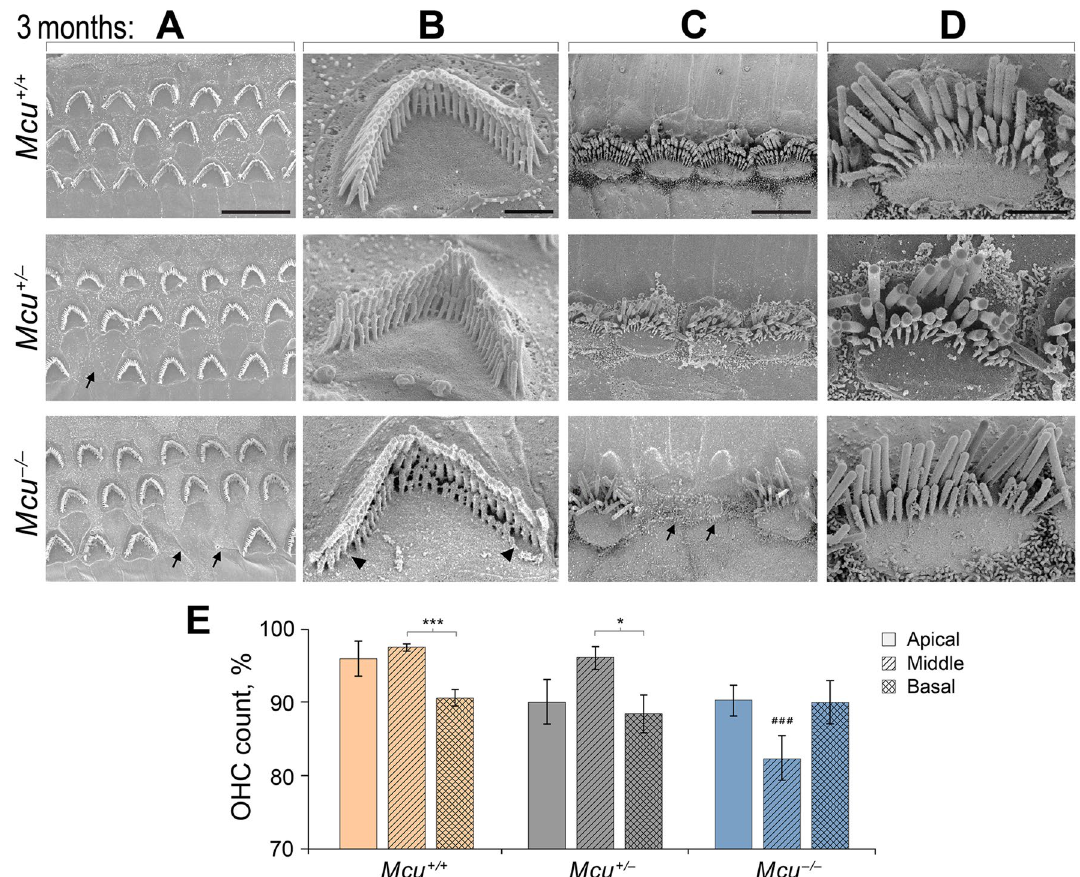
Figure 7. Loss of hair cells in adult Mcu −/− mouse cochlea. ( A – D ) Representative scanning electron micrographs of cochlear hair cells acquired from Mcu + / + (top row), Mcu + /− (middle row), and Mcu −/− FVB/ NJ mice (bottom panel) at P88–P92 time point. ( A ) The typical three-row arrangement of OHCs, ( B ) single OHC stereocilia at high magnification, ( C ) the single row of IHCs, and ( D ) single IHC stereocilia at high magnification are shown. Note the absence of the third (shortest) row of stereocilia in Mcu −/− mice. The arrows in ( A ) and ( C ) indicate missing sensory hair cells and the arrowheads in B indicate the degenerating shortest row of stereocilia in OHCs. ( E ) The SEM images were categorized based on their cochlear region (apical, middle, and basal turn), and the percentage of missing OHCs were plotted (mean ± SEM). ### p < 0.001 in comparison to the middle region of Mcu + / + and Mcu + /− mice, * p < 0.05, *** p < 0.001, Kruskal–Wallis with Dunn’s multiple comparison tests. The number of mice is 12 ( Mcu + / + ), 13 ( Mcu + /− ), and 18 ( Mcu −/− ). Scale bars are (in µm): 10 ( A ); 1 ( B ); 5 ( C ); 2 ( D